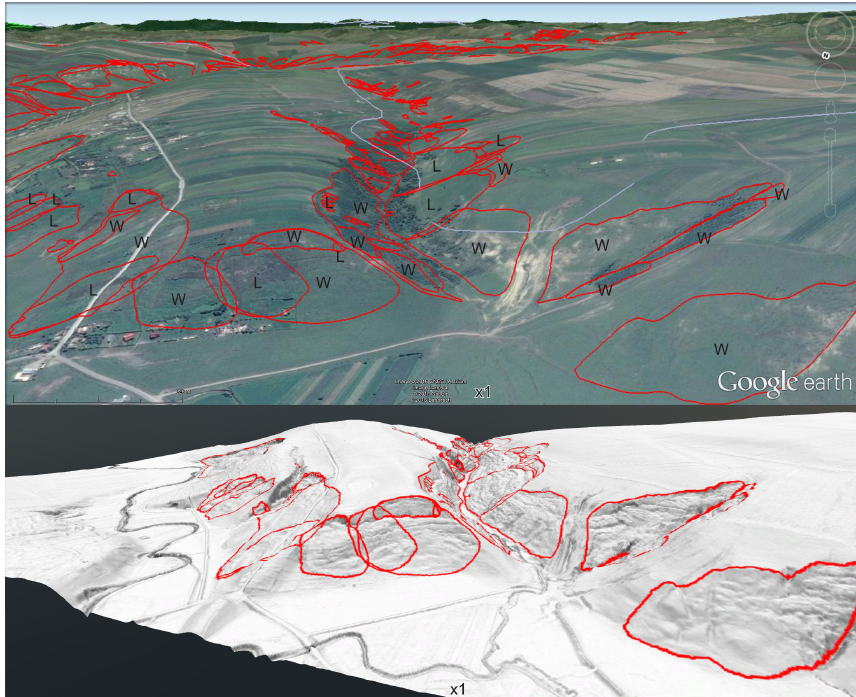
Figure 2. Geomorphologic cases of long (L) and wide (W) types of landslides from the study area. The top panel is a 3-D view Google Earth image; the bottom panel is a 3-D view of the lidar DEM shading. Both views show the landslide polygons overlaid in